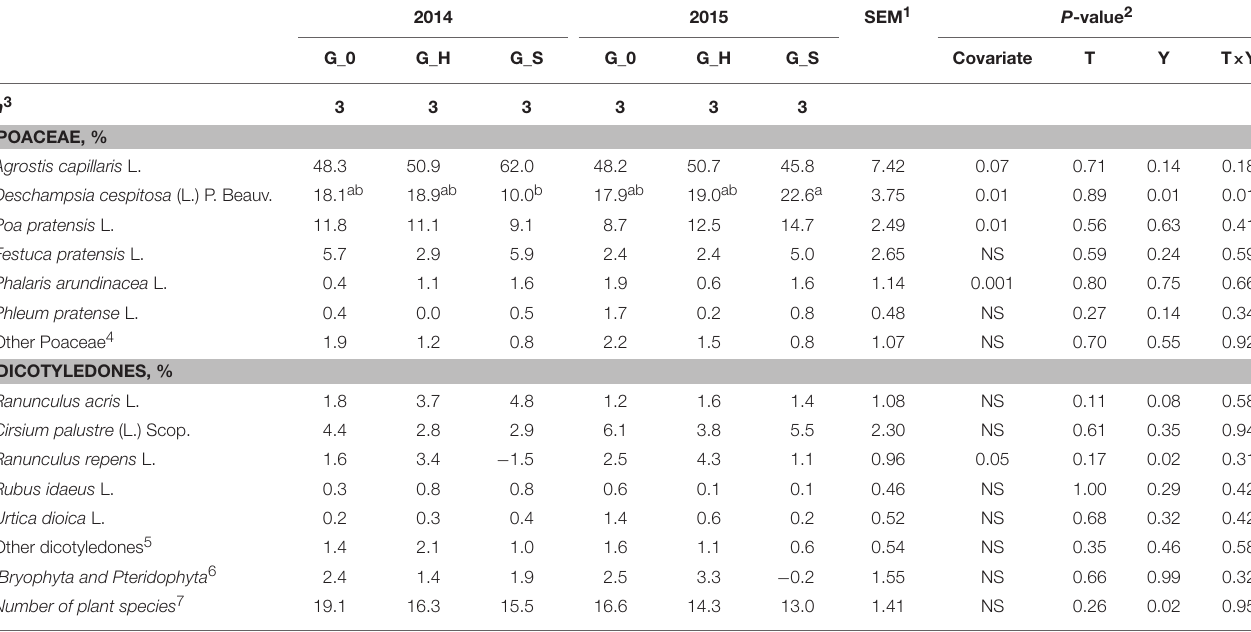
TABLE 1 | Effect of grazing treatment [control without grazing (G_0), grazing with heifers (G_H) or grazing with sheep (G_S)] and year on botanical composition in autumn (Period 4) of 2014 and 2015 estimated using the dry-weight-rank method (Jones and Hargreaves, 1979). 2014 2015 SEM 1 P -value 2 G_0 G_H G_S G_0 G_H G_S